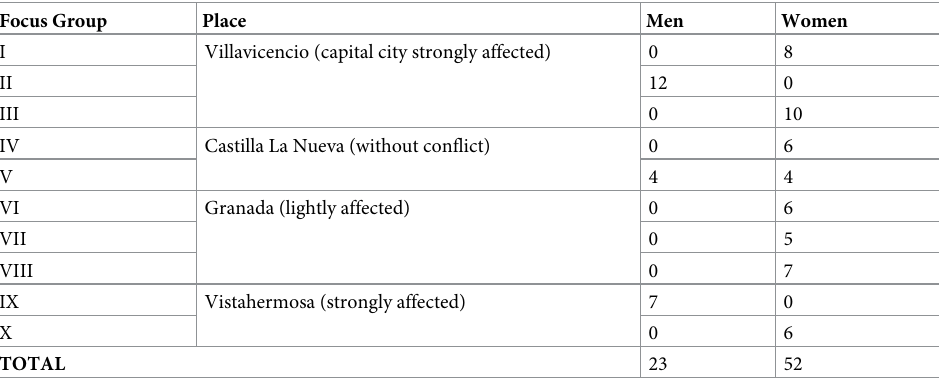
Table 1. Focus groups by location, gender and number of participants. Focus Group Place Men